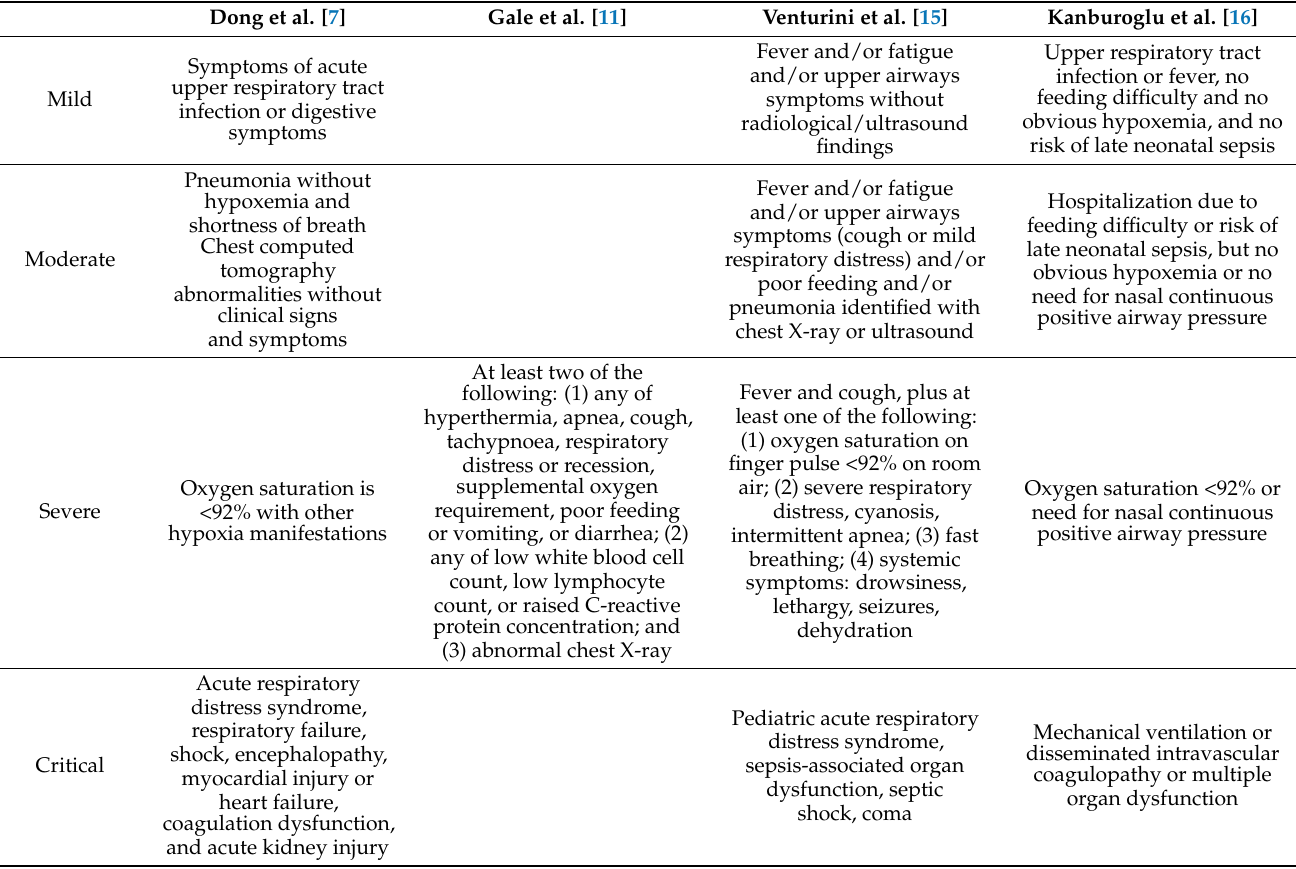
Table 1. Characteristics of different